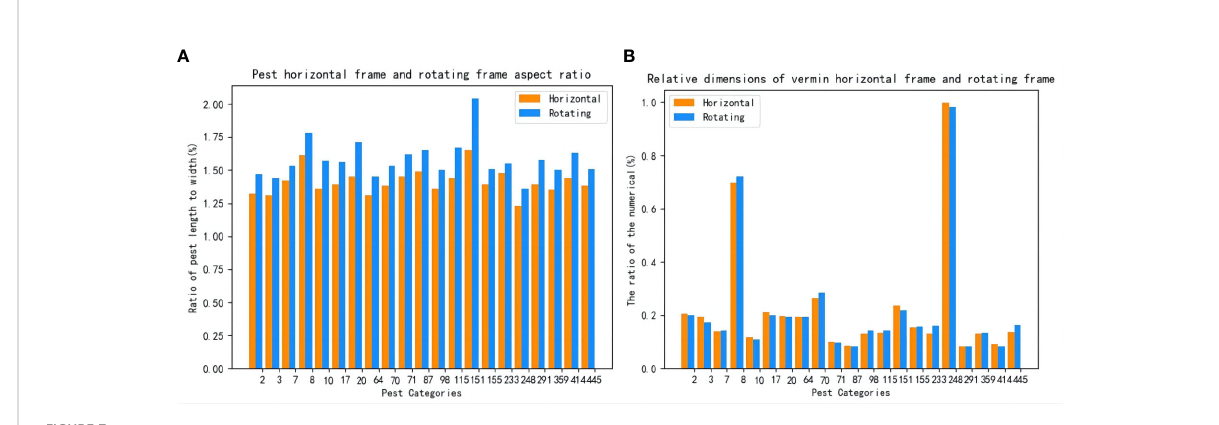
FIGURE 7 Left panel (A) shows the aspect ratio data of A single class of pests, and right panel (B) shows the proportion of the relative original size of A single type of pest.